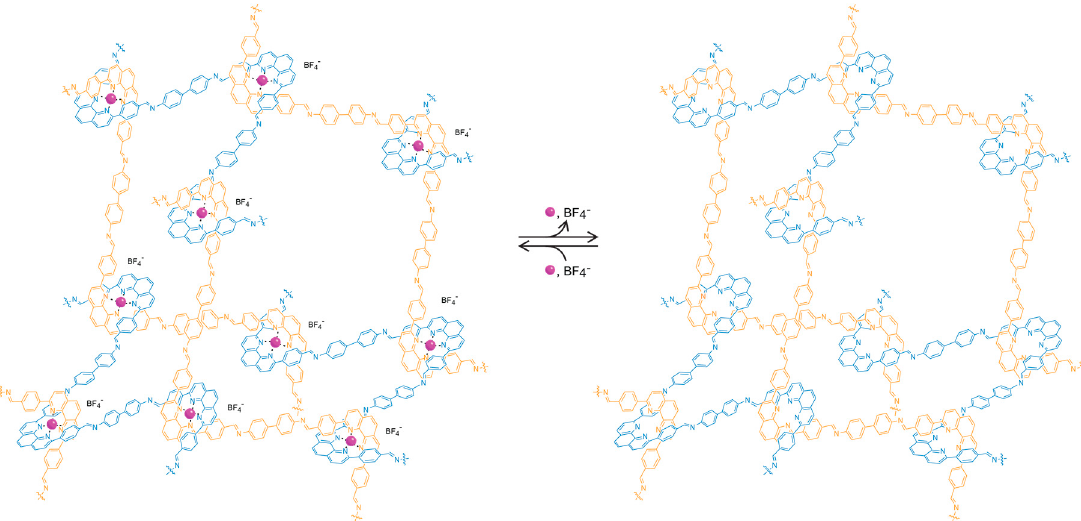
Figure 3. Illustration of the adamantane cages of metalated and unmetalated COF-505. The open structure of the framework allows for reversible post-synthetic metalation/demetalation with full retention of the overall structure.